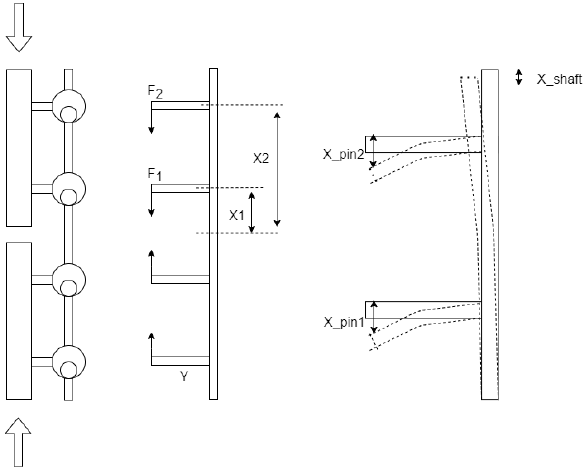
Figure 10. Simplification of system. System is divided into 2 sections from the mid-point of the fracture. x1-vertical distance from mid-point of fracture site to center of pin 1. x2-vertical distance from mid-point of fracture site to center of pin 2. F1, F2-vertical force acting on each pin. Spring